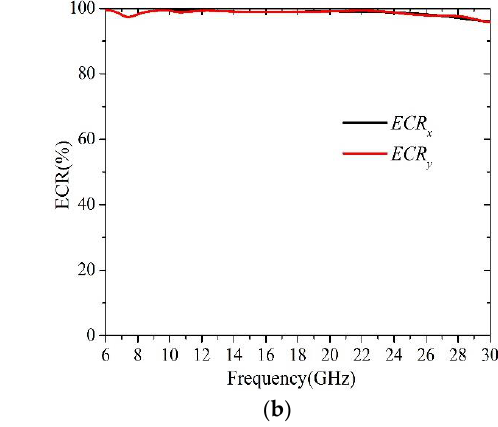
6 of 15 Figure 3. Simulation results for normal x -polarized incidence. ( a ) Amplitude; ( b ) Phase difference; ( c ) Axial ratio. The phase difference xy φ  is plotted in Figure 3b. It can be seen that xy φ  was nearly equal to an odd multiple of π/2 in the whole frequency region, indicating that circular polarizations were created by the x -polarized incident wave in the frequency ranges of 8.42 – 12.32 GHz and 18.74 – 29.73 GHz. Accordingly, the AR is plotted in Figure 3c, and it can clearly be seen that the AR was less than 3 dB at 8.42 – 12.32 GHz and 18.74 – 29.73 GHz, corresponding to a relative bandwidth of 37.61%, and 45.35%, respectively. Moreover, the AR remained below 1 dB in the frequency ranges of 8.84 – 11.46 GHz and 20.23 – 26.49 GHz.